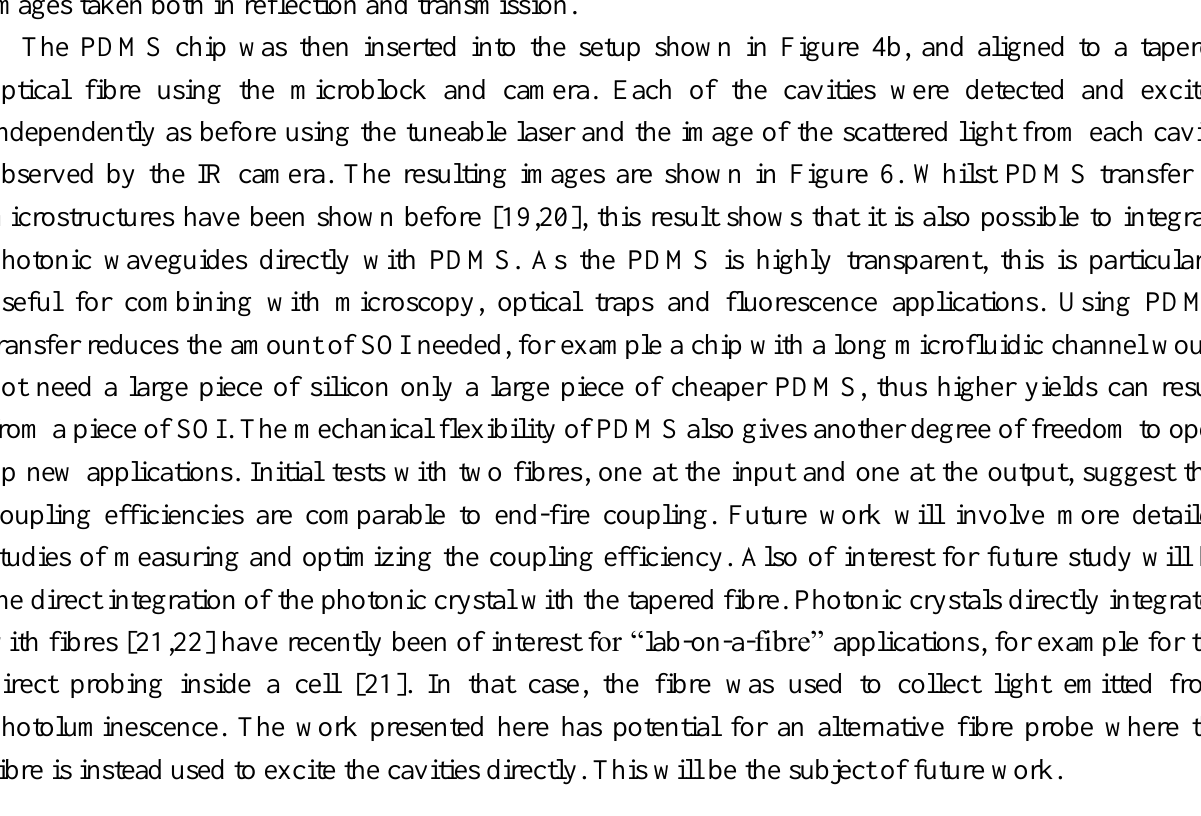
Figure 5. Photonic crystal waveguides transferred to PDMS substrate ( a ) and ( b ) viewed in reflection and ( c ) viewed in transmission from light